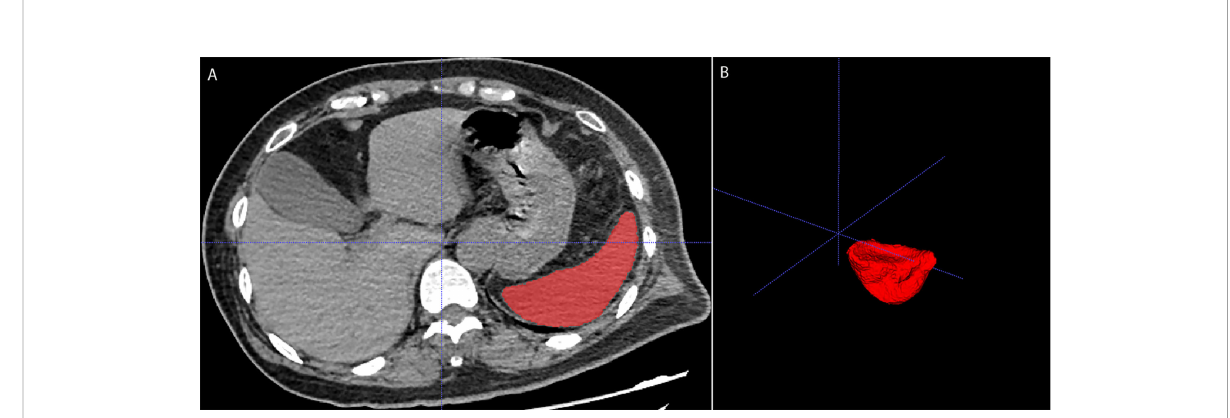
FIGURE 1 Measurement of splenic volume on unenhanced chest computed tomography using ITK-SNAP software. (A) showed the spleen segmentation, while (B) presented 3D model of the